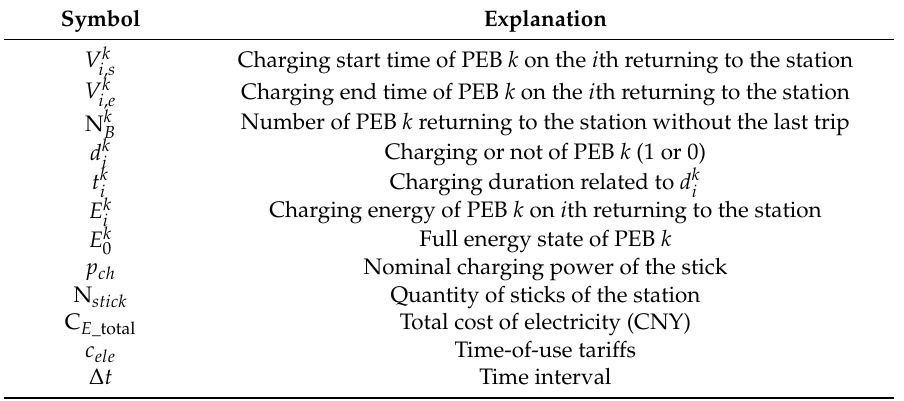
Table 4. List of some symbols used in the operation